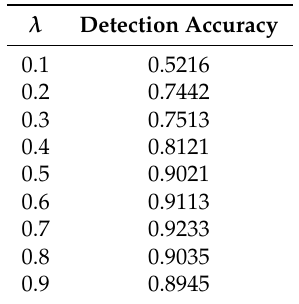
Table 5. λ test for Loss L.